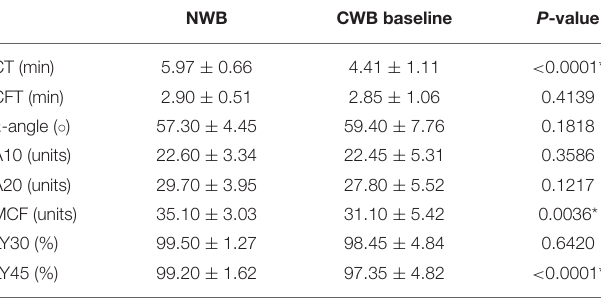
TABLE 1 | Results of NWB compared to CWB baseline.